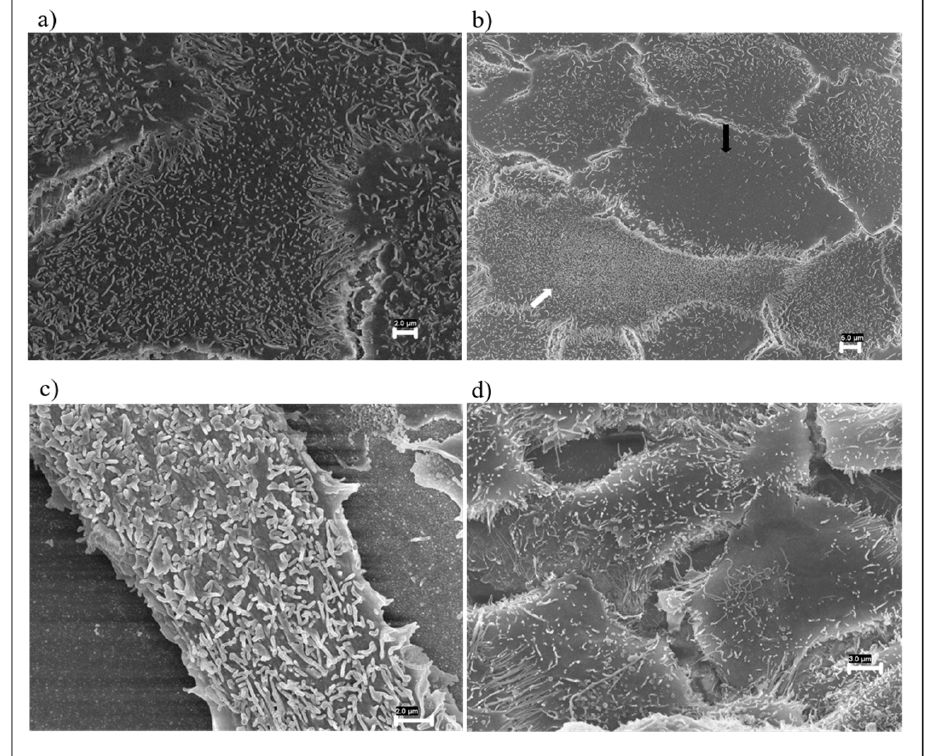
Figure 4. FESEM images of HaCaT cells exposed to: ( a ) EUT (Bar 2 μ m) and ( b ) EP1 (Bar 5 μ m), where white and black arrows indicate microvilli accumulation and a reduction in the number of microvilli on the cell surface, respectively; ( c ) EP1GNPs (Bar 2 μ m), which displays the presence of enlarged microvilli on cell membrane; ( d ) EP2GNPs (Bar 3 μ m). HaCaT cells show elongated micro ‐ villi.